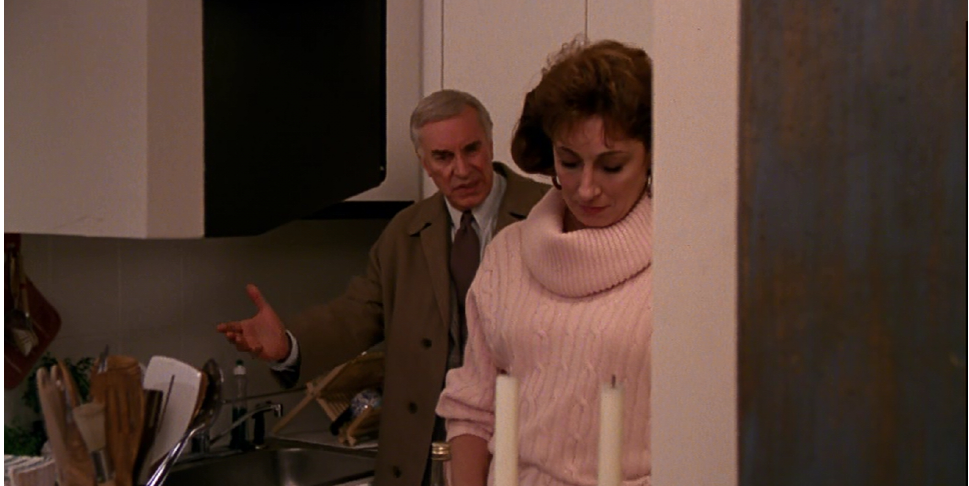
Figure 2: Judah with Dolores Paley (Anjelica